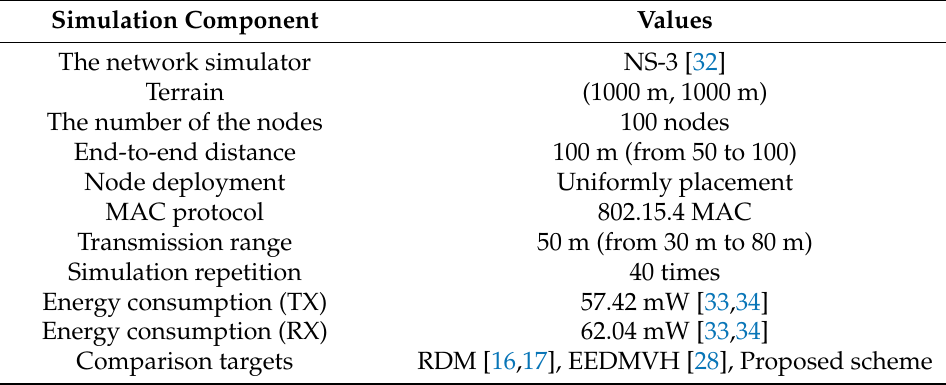
Table 1. The components of the simulation